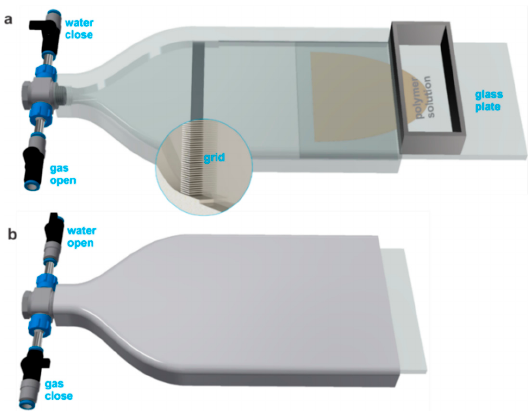
Figure 1. The set-up used for the casting of flat sheet membranes on the glass plate. ( a ) The glass plate was put slightly inside the envelope and the doctor blade was placed on it. To cast the polymer solution, the glass plate was moved inwards while the gas flow was on. ( b ) After a certain t g , the non-solvent flow was introduced and simultaneously the gas flow was closed. The magnified area shows a grid in the internal view of the casting